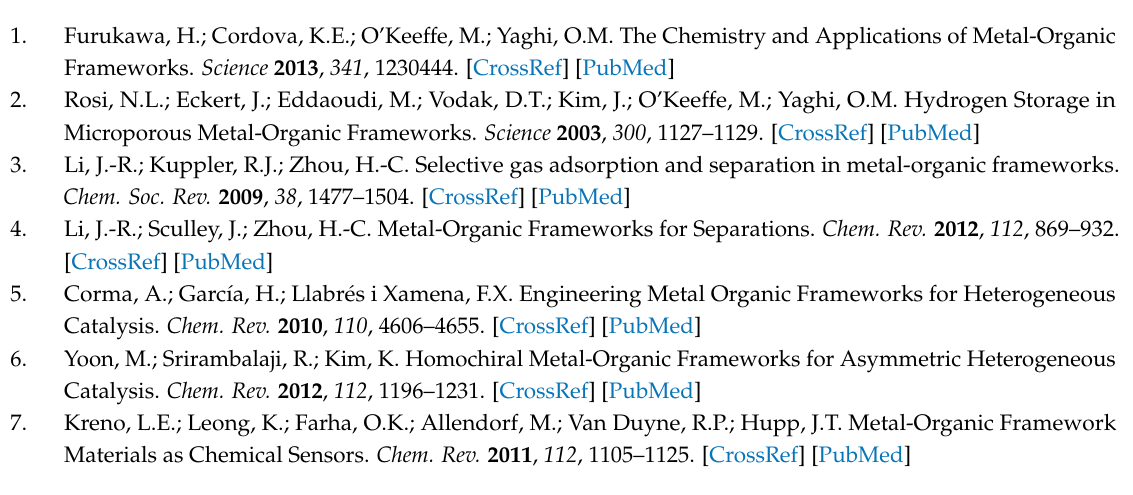
Figure S1: AFM image of a pure CA film on quartz prepared by spin-coating; Figure S2: Photoluminescence spectra of double-sided tape, adhesive residue after peeling off the tape, MOF adhered to the tape and MOF adhered to the adhesive residue; Figure S3: Photoluminescence spectra of an MOF film prepared with the adhesive residue left by an adhesive tape and after its exposure to a DNT saturated environment; Figure S4: Photoluminescence spectra and pictures of an MOF film prepared with the adhesive residue left by an adhesive tape before and after typical experimental manipulation; Figure S5: Quenching percentages for films prepared at 2, 4, and 6 bar; Figure S6: Thickness of CA films prepared from CA solutions at different